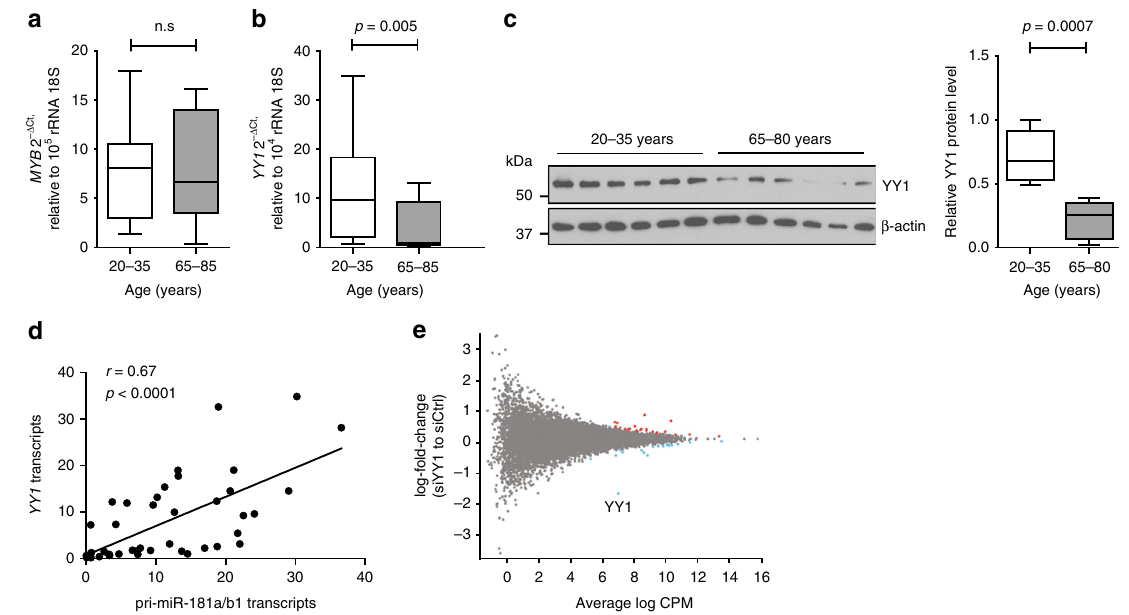
Fig. 3 Age-associated loss in YY1 expression accounts for reduced pri-miR-181a/b1 expression. a MYB transcripts in naïve CD4 T cells were quanti fi ed by qPCR. Results for 20 – 35-year-old ( n = 16) and 65 – 85-year-old ( n = 18) individuals are shown as box plots of MYB transcripts relative to 18s rRNA. Comparison was done by two-tailed unpaired t test. b YY1 transcripts in naïve CD4 T cells from young ( n = 21) and old ( n = 23) adults are compared by two-tailed unpaired t test. c YY1 protein expression in naïve CD4 T cells from young and older adults are compared by two-tailed unpaired t test. Representative Western blots (left) and summary statistics of YY1 protein relative to β -actin from young ( n = 9) and older ( n = 9) adults (right). d YY1 transcripts are correlated with pri-miR-181a/b1 expression using two-tailed Pearson's correlation. e MA plot of RNA-seq data comparing transcriptome of young ( n = 3) naïve CD4 T cells 48 h after transfection with control siRNA and YY1 siRNA #1. Signi fi cant upregulation by YY1 silencing is indicated by red, and downregulation by blue using an adjusted p value cutoff of